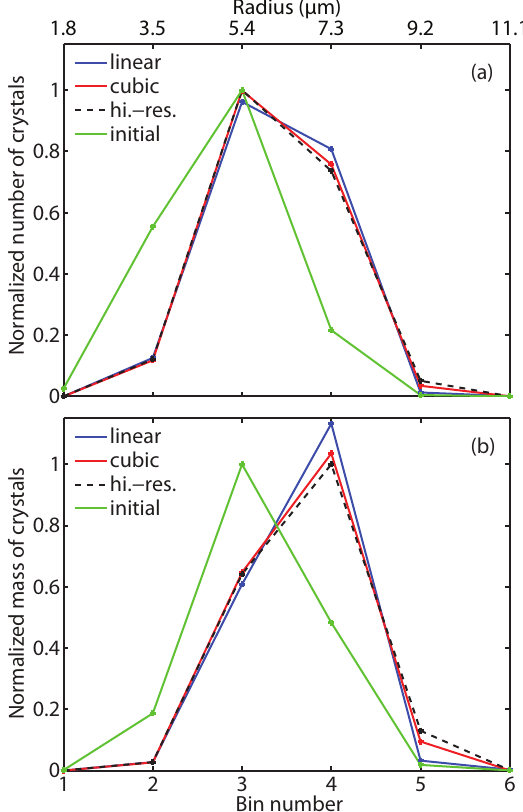
Fig. 3. Numerical solutions in (a) number and (b) mass of ice crys- tals obtained by the linear and cubic schemes at 30 min in the de- positional growth problem. The low resolution solutions (blue and red curves) are obtained at 6-bin-resolution. The high resolution so- lution (black, dashed curve) is obtained at 200-bin-resolution. The initial and final solutions are normalized by the maximum of the high resolution solutions at respectively the initial and final time. The radii corresponding to the masses at the bin centers are indi- cated at the top of the plot. The bin numbers are indicated at the bottom of the plot.